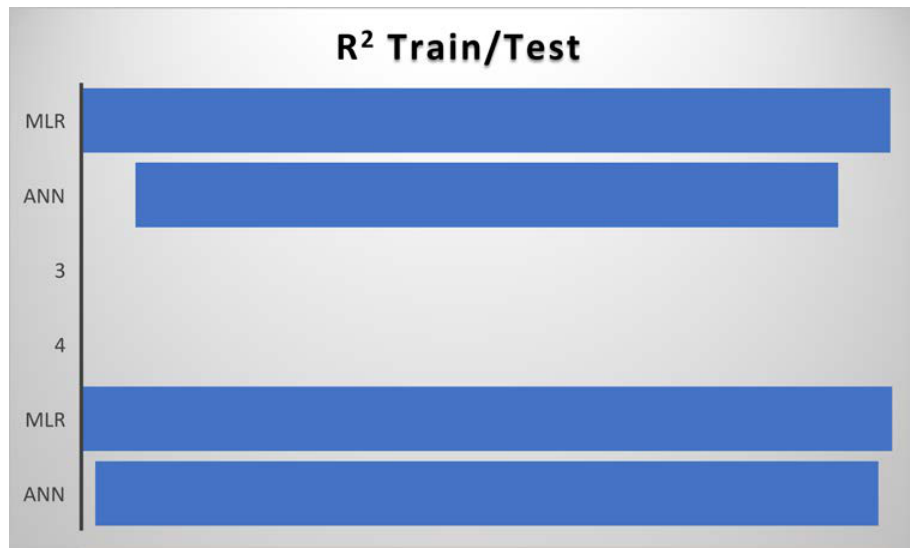
Figure 10. Funnel chart of determination coefficients (R 2 ) of the models in both the training and testing stages.